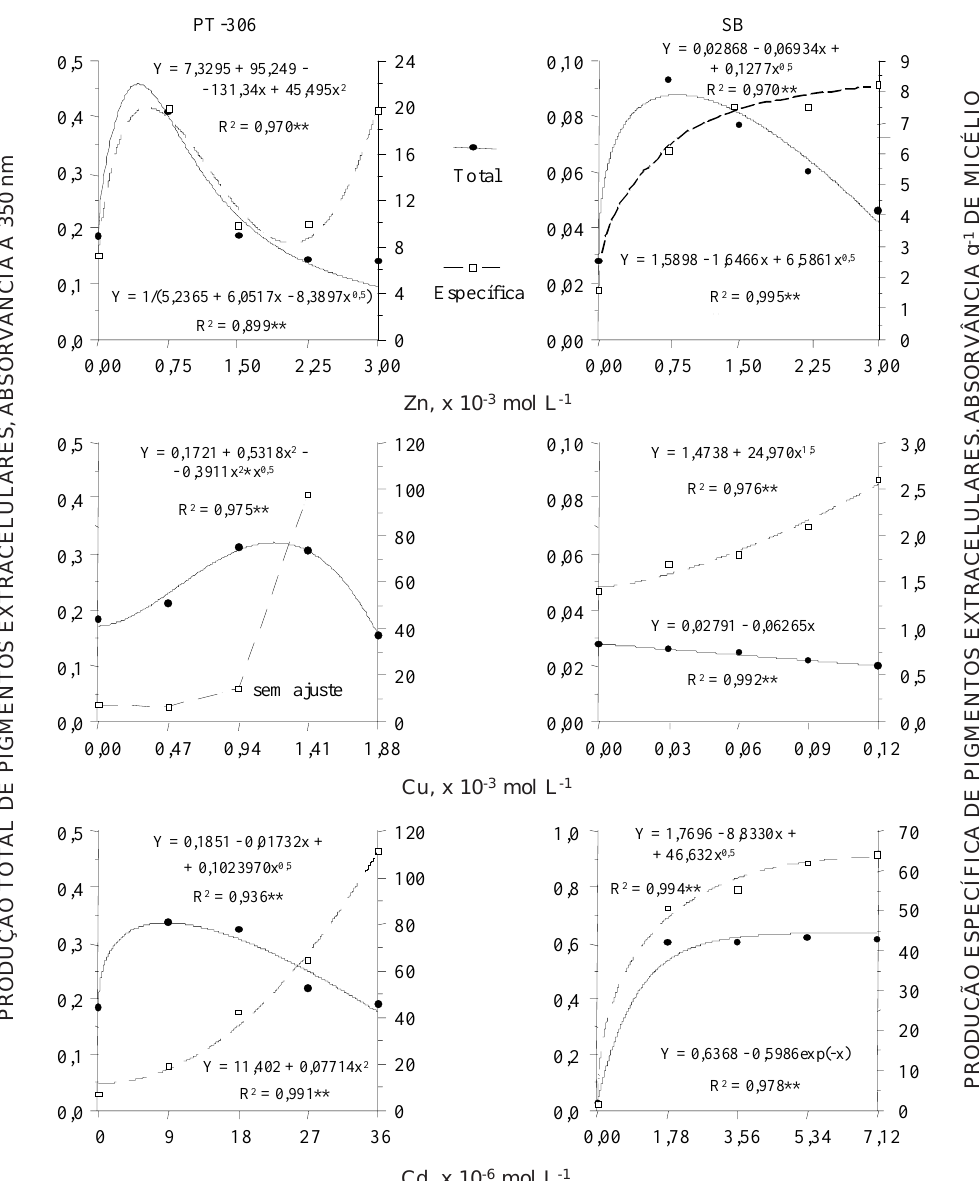
Figura 2. Produção total de pigmentos extracelulares, determinada e expressa pela absorção da luz do visível a 350 nm, e produção específica de pigmentos (absorbância 350 nm por grama de micélio seco) na solução do meio de cultura (MNM) com doses crescentes de Zn, Cu e Cd onde foram crescidos os isolados PT-306 e